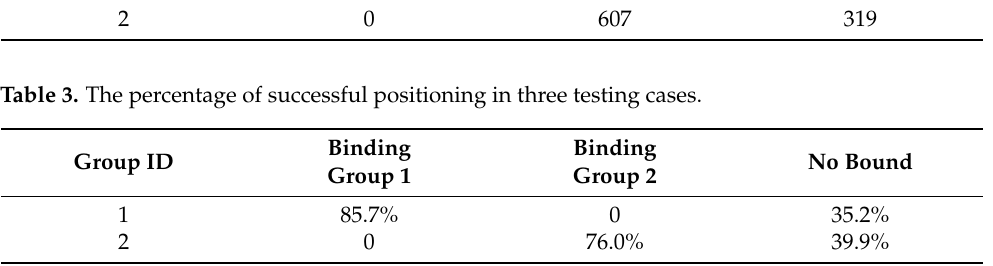
Table 3. The percentage of successful positioning in three testing cases.